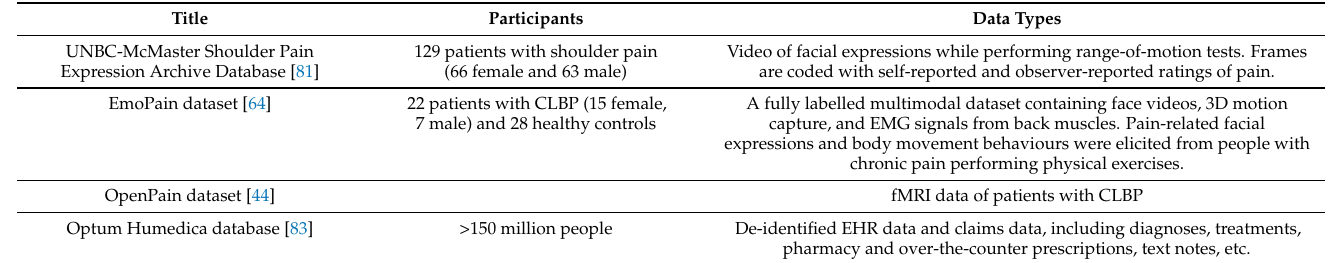
Table 2. Datasets available for academic